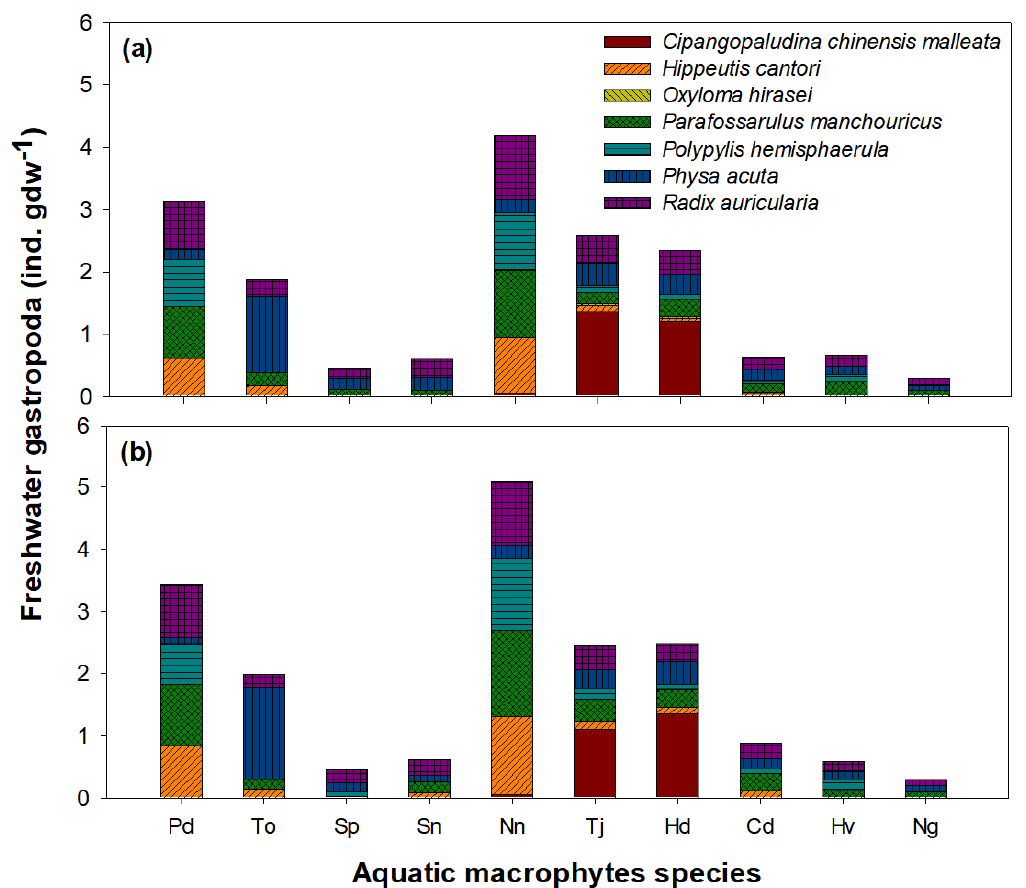
Figure 6. Abundance and species number of gastropods among macrophyte species. ( a ) Spring and ( b ) autumn. Pd, Pas- palum distichum ; To, Typha orientalis ; Sp, Spirodela polyrhiza ; Sn, Salvinia natans ; Nn, Nelumbo nucifera ; Tj, Trapa japonica ; Hd, Hydrocharis dubia ; Cd, Ceratophyllum demersum ; Hv, Hydrilla verticillata ; Ng, Najas graminea . Table 3. Seasonal mean abundance of major epiphytic algal groups collected from each macrophyte species (cells/gdw − 1 ) at the study area. Pd, Paspalum distichum ; To, Typha orientalis ; Sp, Spirodela polyrhiza ; Sn, Salvinia natans ; Nn, Nelumbo nucifera ; Tj, Trapa japonica ; Hd, Hydrocharis dubia ; Cd, Ceratophyllum demersum ; Hv, Hydrilla verticillata ; Ng, Najas graminea .